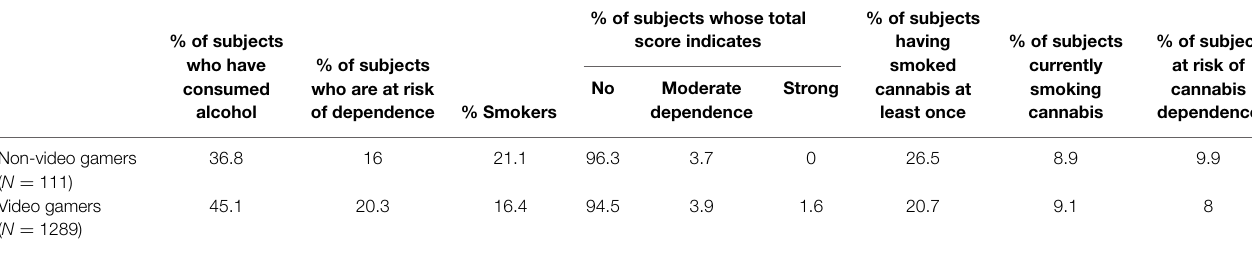
% of subjects who have